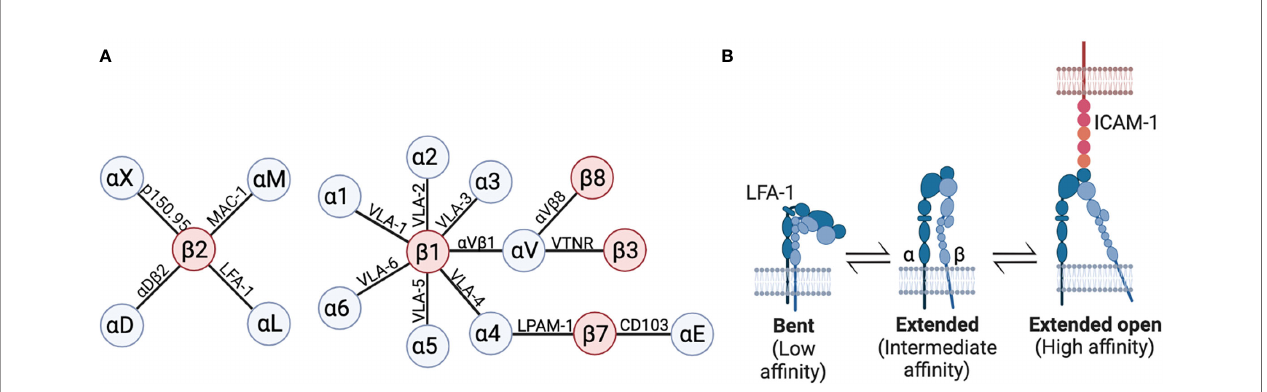
FIGURE 2 | Integrins in T cells. (A) Schematic of integrin chains expressed in T cells with a integrin chains in blue, and b integrin chains in red. Lines indicate which integrin chains form heterodimeric integrins, and names over lines are commonly used names of the resulting integrin. (B) LFA-1 ( a L b 2) integrin in a bent/closed conformation with low af fi nity, extended/closed conformation with intermediate af fi nity, and extended open conformation with high af fi nity. Figure made